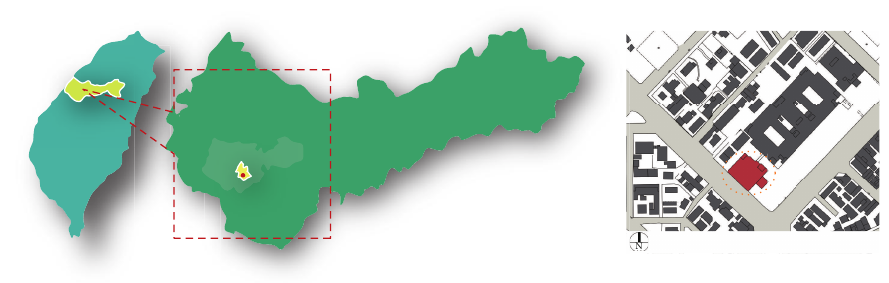
Figure 1: The field test site for this research.